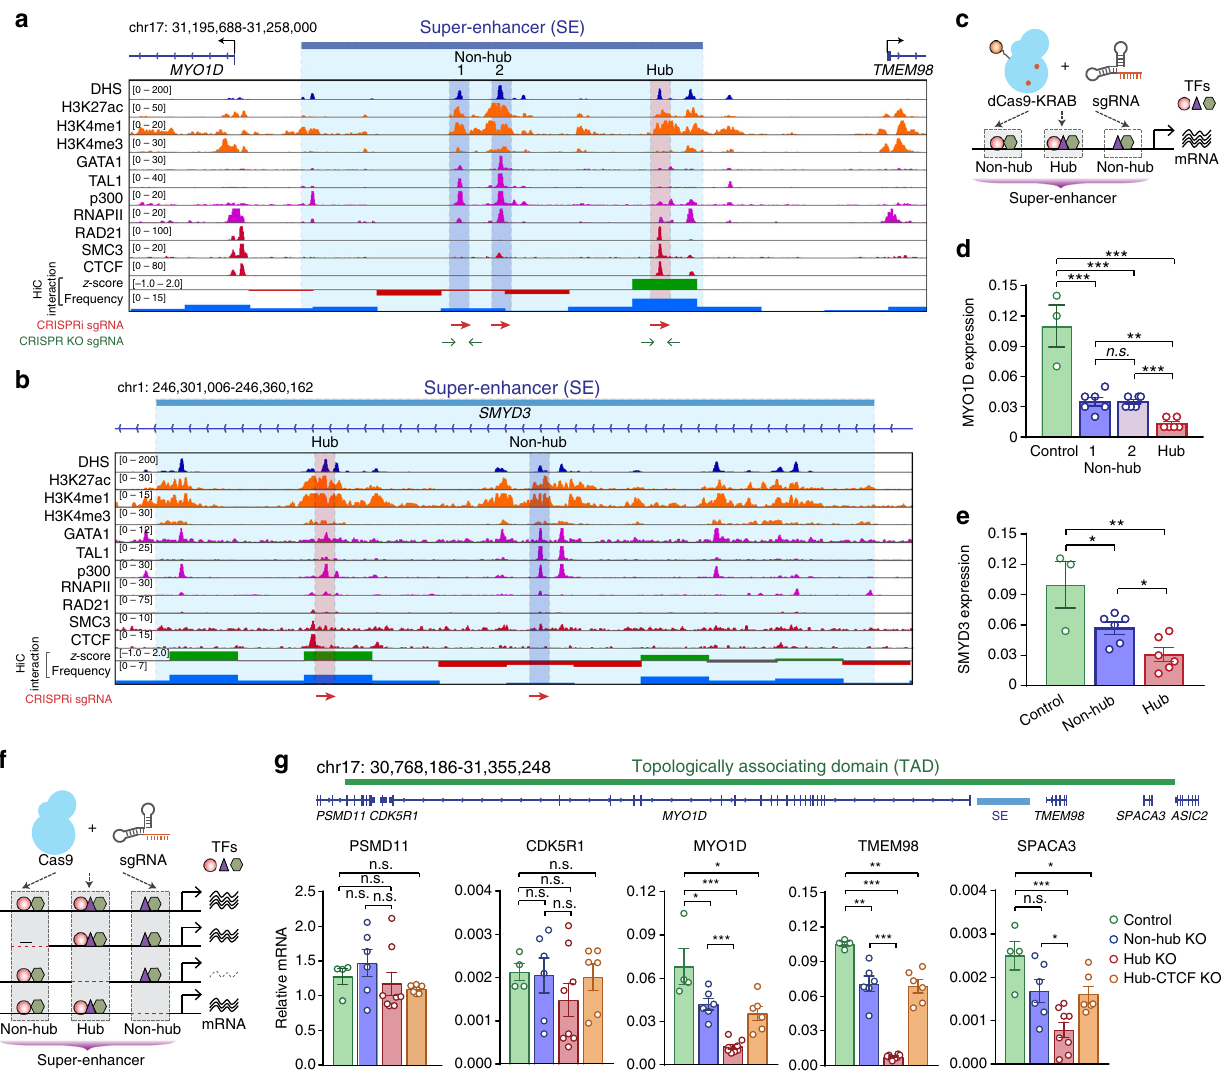
Fig. 5 In situ genome editing reveals distinct requirement of hub vs non-hub enhancers in SE function. a Chromatin signatures and TF occupancy at the MYO1D SE locus in K562 cells are shown. The identi fi ed hub and non-hub enhancers are depicted by red (hub) and blue (non-hub) lines, respectively. The Hi-C chromatin interaction z-score and frequency at 5 kb resolution is shown at the bottom. The positions of sgRNAs used for CRISPRi or CRISPR-Cas9- mediated knockout analyses are shown as arrowheads. b Chromatin signatures and TF occupancy at the SMYD3 SE locus in K562 cells are shown. c Schematic of CRISPRi-mediated repression of hub or non-hub enhancers. d , e Expression of MYO1D and SMYD3 mRNA in untreated (control), CRISPRi- mediated repression of hub or non-hub enhancers. The mRNA expression levels related to GAPDH determined by qRT-PCR are shown. Each colored circle represents an independent biological replicate experiment. Results are means ± s.e.m. of 3 or 6 independent experiments. P values were calculated by two- sided Student ’ s t -test. * P < 0.05, ** P < 0.01, *** P < 0.001, n.s. not signi fi cant. f Schematic of CRISPR-Cas9-mediated knockout of hub or non-hub enhancers. g Expression of all genes within the SE-containing TAD domain in unmodi fi ed (control), CRISPR-Cas9-mediated knockout of hub, non-hub enhancers or the CTCF binding site within the hub enhancer. The mRNA expression levels relative to GAPDH are shown. Each colored circle represents an independent single-cell-derived homozygous enhancer knockout clone. A schematic of the SE-containing TAD domain and associated genes are shown on the top. Results are means ± s.e.m. of at least 4 independent experiments. P values were calculated by a two-sided Student ’ s t -test. * P < 0.05, ** P < 0.01, *** P < 0.001, n.s. not signi fi